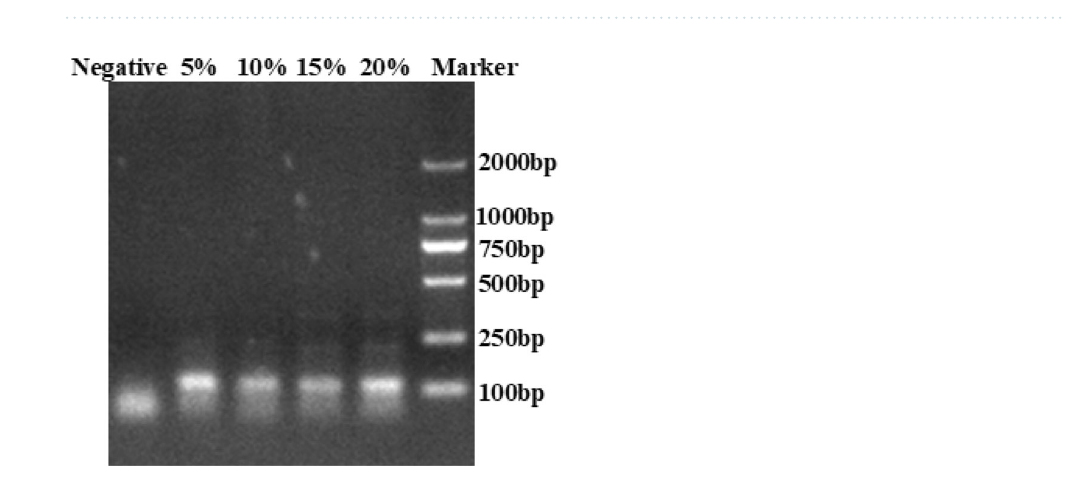
Figure 7. Dissolution effect. ( a ) Magnetic bead dissolution process. ( b ) Dissolution time of PVA with different concentrations.